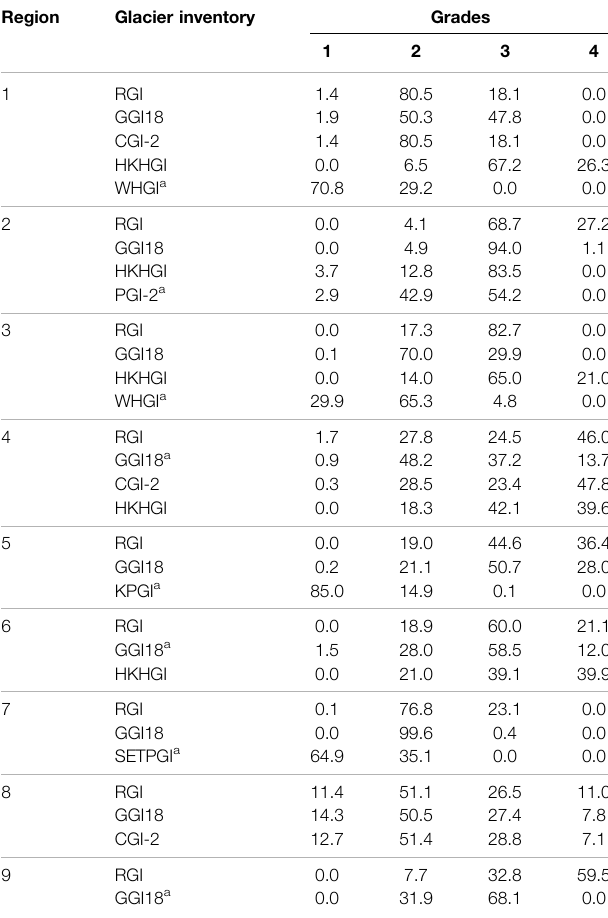
a indicates the best-quality inventory for each